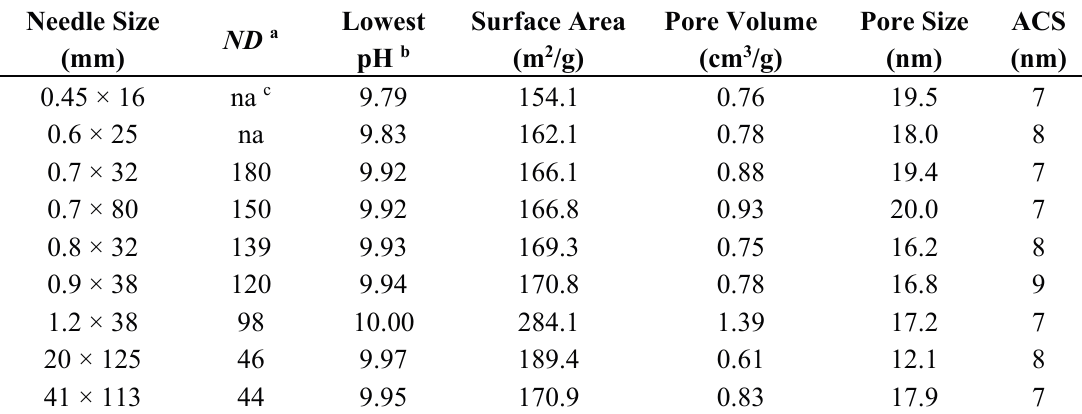
Table 2. Effect of needle size on BET surface area, pore size and crystallite